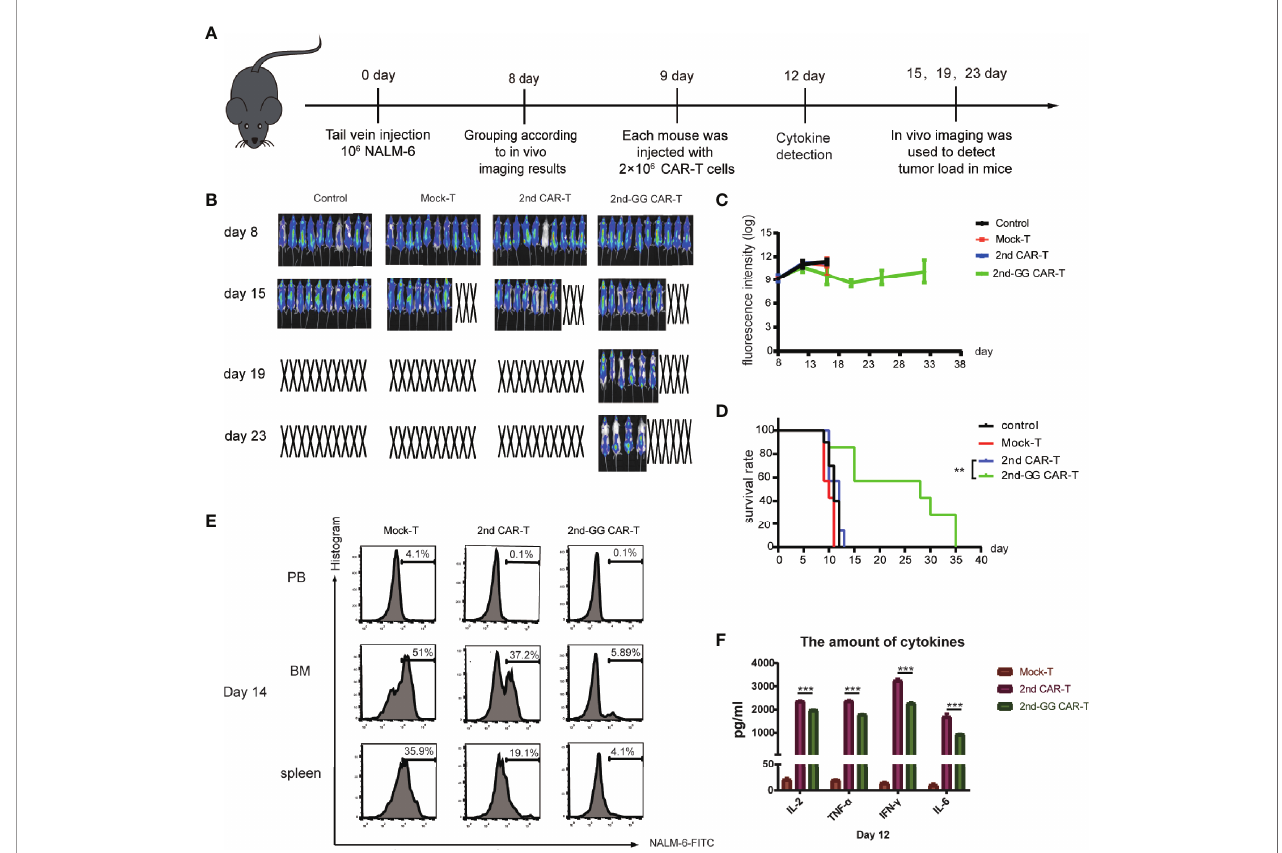
FIGURE 4 | The antitumor ef fi cacy and cytokines release of different CAR-T cells in high tumor load models. (A) Diagrammatic representations of the experimental procedures. (B) Representative bioluminescent images are shown. (C) Overall survival curves of NALM-6 -GFP-luc challenged mice (n = 8). (D) Tumor burden-total fl ux (log) for each mouse was quanti fi ed and averaged by group. (mean ± SEM) (E) On day 14, one mouse was randomly euthanized from the Mock-T, 2nd CAR-T and 2nd-GG CAR-T groups. Cell suspensions from peripheral blood, bone marrow and spleen were collected and ground for fl ow cytometry detection. Since the NALM-6 cells were engineered to express GFP, the tumor load was re fl ected by the expression percentage of GFP+ cells. (F) On day 12, approximately 1,000 µL of blood were collected from the caudal vein of each mouse to detect the concentration of human IL-2, TNF- a , IFN- g , and IL-6 using an ELISA-kit. (mean ± SD, n = 2). **P < 0.01, ***P <